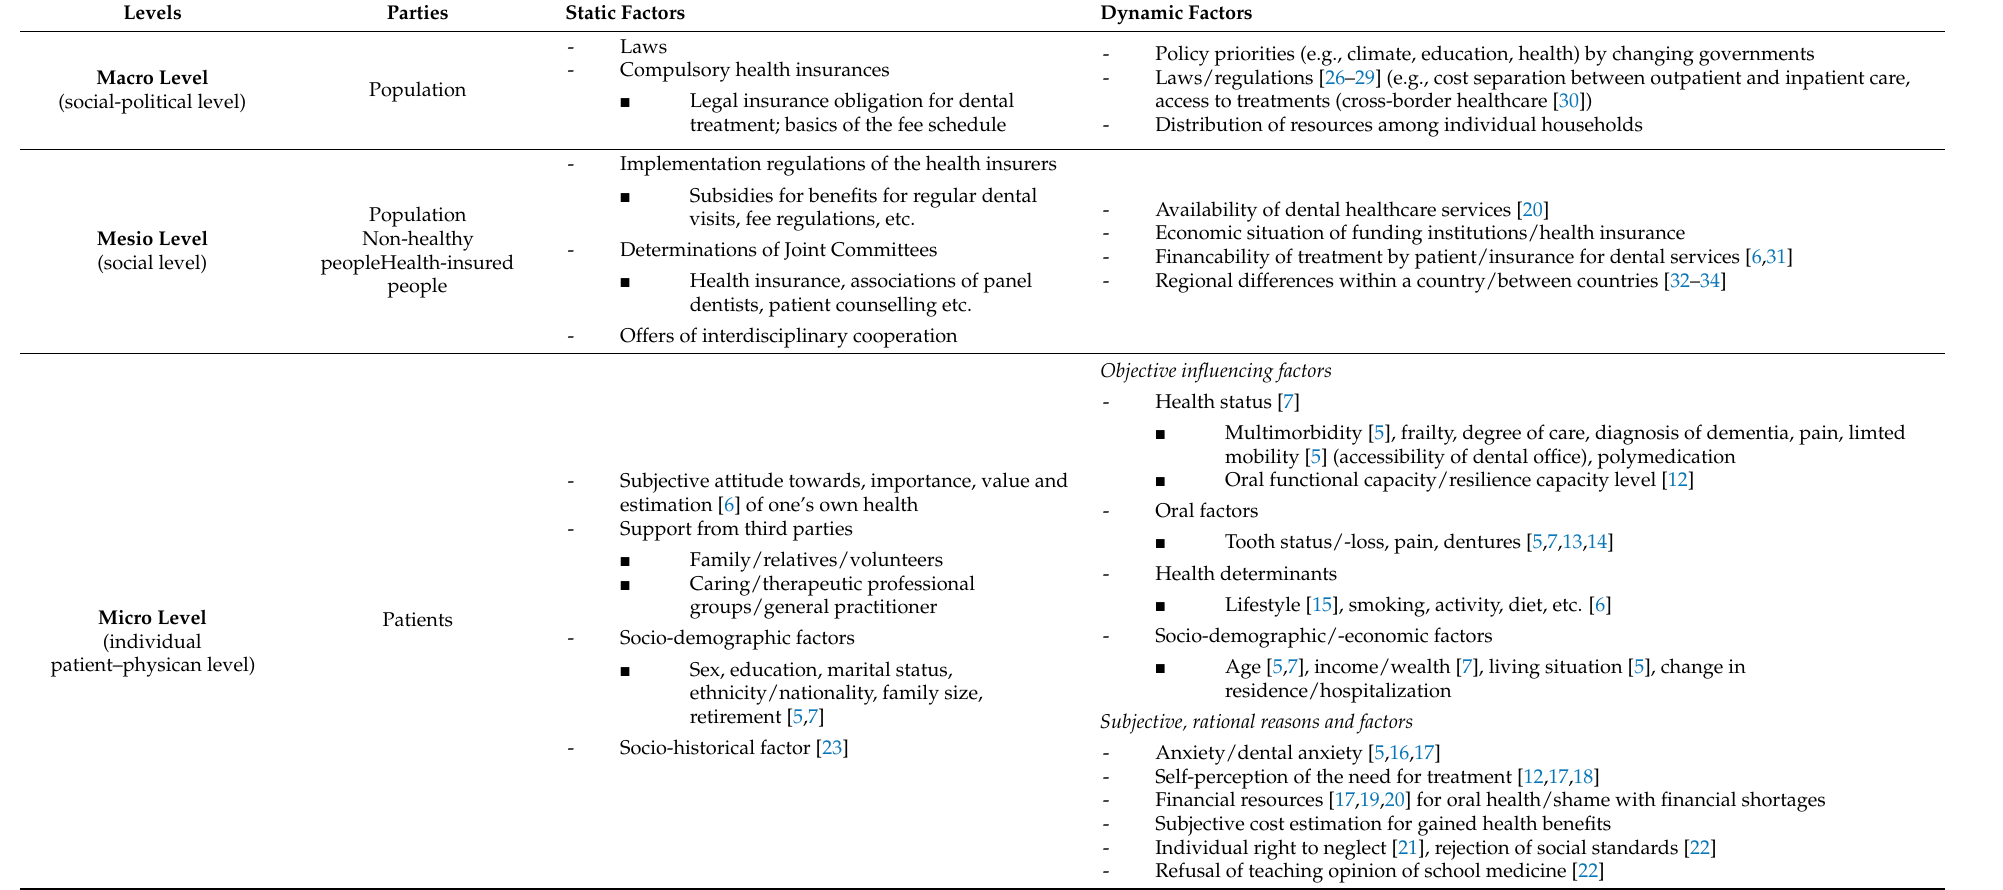
Table 1. Static (not individually influenceable) and dynamic (easily changeable) influencing factors, organized with magnitude of importance within the different levels of the healthcare system, which are able to model the risk of a reduced utilization of dental healthcare services (modeled after Nitschke et al., 2015